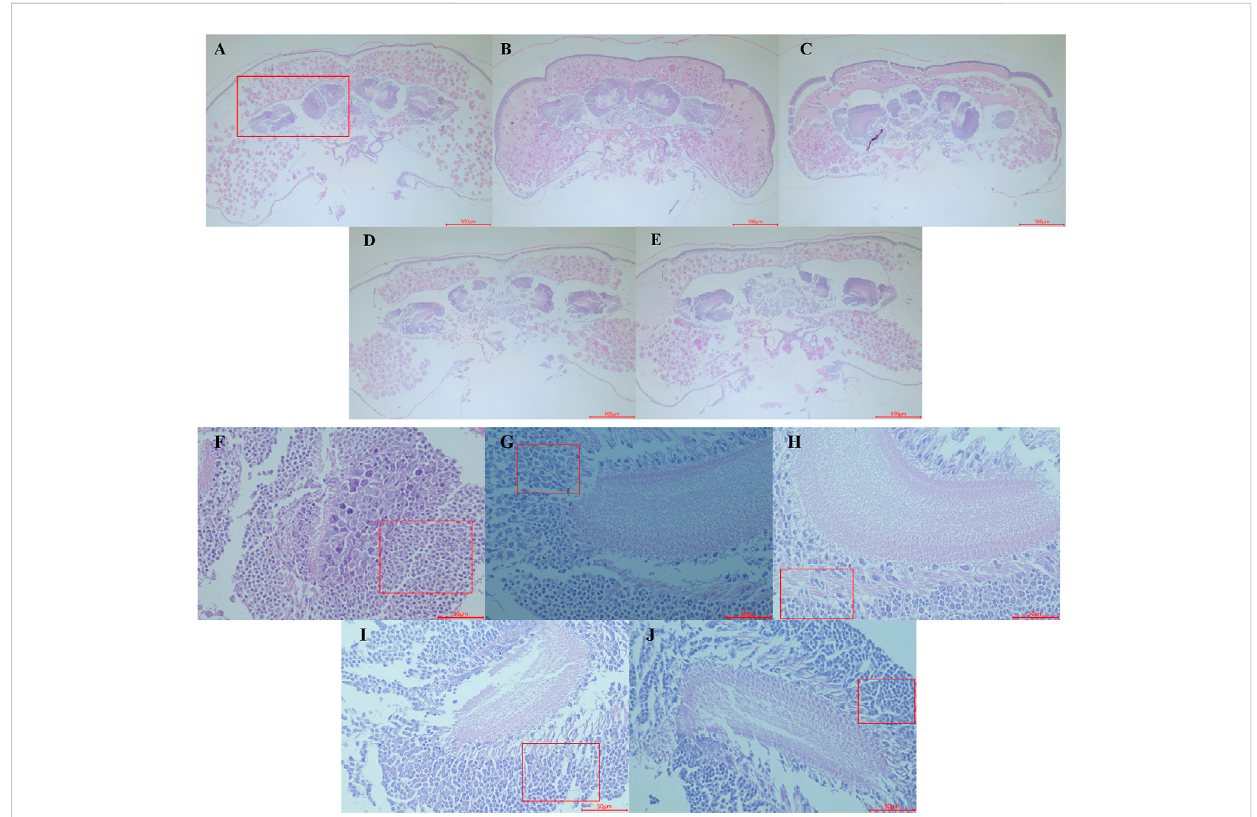
FIGURE 3 Observation of Haematoxylin and Eosin staining paraf fi n section of the early pupa of honeybee head. (A – C) represents the head section of the control group on the fi rst, second and third days of pupal stage (control groups, 20×). (D,E) represents the head section of the fi rst day pupal in the treatment group for 24 and 48 h respectively. (F – H) represents mushroom body (red box area in (A) ) sections of the fi rst, second and third days pupal (control groups, 400×); (I,J) represents the mushroom body area section of the fi rst day pupal in the treatment group for 24 and 48 h